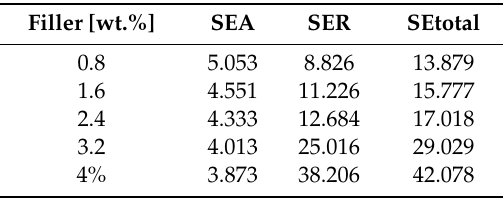
Table 3. Results of shielding effectiveness of MWCNT/PLA/PEG for different MWCNTs loading at 12 GHz. Filler [wt.%] SEA SER